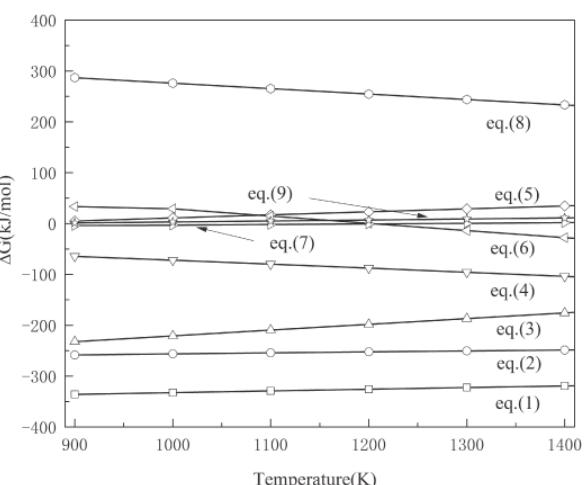
Fig. 3: The reaction curves of BN powder with different H 2 O/air